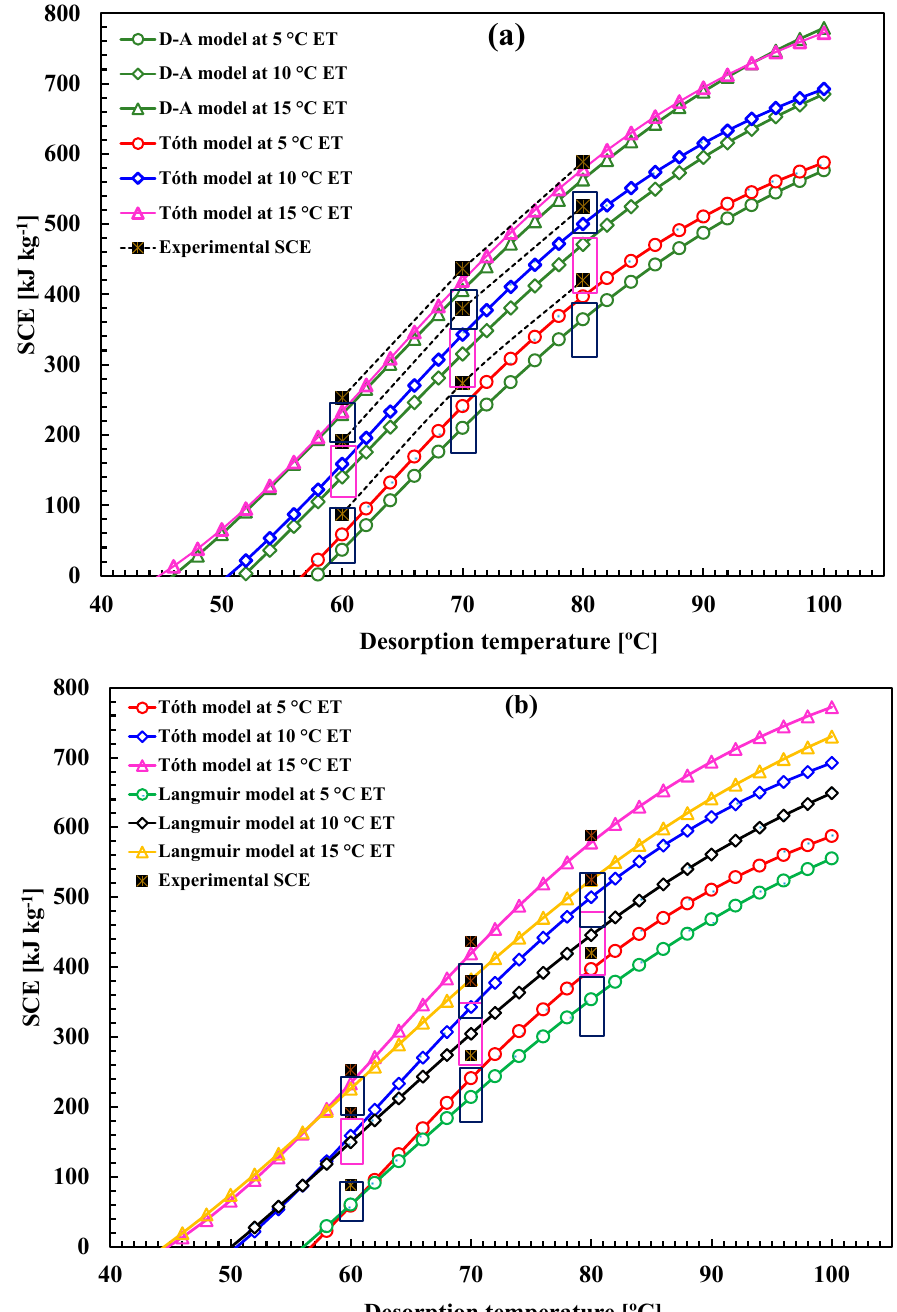
Figure 4. Experimental SCE comparisons with, ( a ) T ó th vs. D-A, and ( b ) T ó th vs. Langmuir model of Maxsorb III/ethanol adsorption pair for different evaporating temperatures.